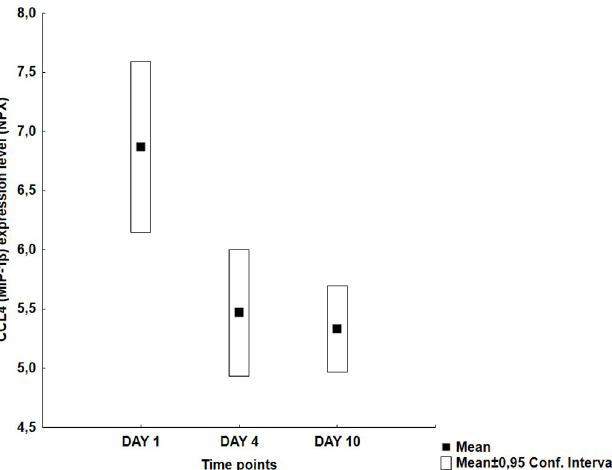
Fig 1. Group A example; CCL4 (MIP-1ß): Temporal pattern of protein expression level (mean NPX ± 0.95 CI) for C-C motif chemokine ligand 4 (CCL4) a.k.a. macrophage inflammatory protein-1ß (MIP-1ß). Statistically significant early peak (mean day 1 vs day 4 values = 6,86 vs 5,46; p < 0,005) but no significantly decreasing trend since values seemed to stabilize between day 4 and 10 (5,46 vs 5,33; p = 0,52).